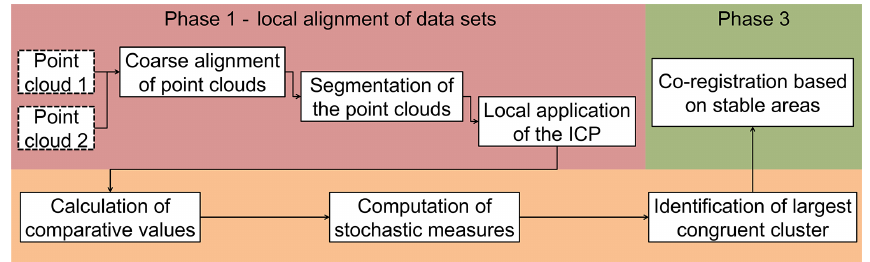
Figure 1. Workflow of the